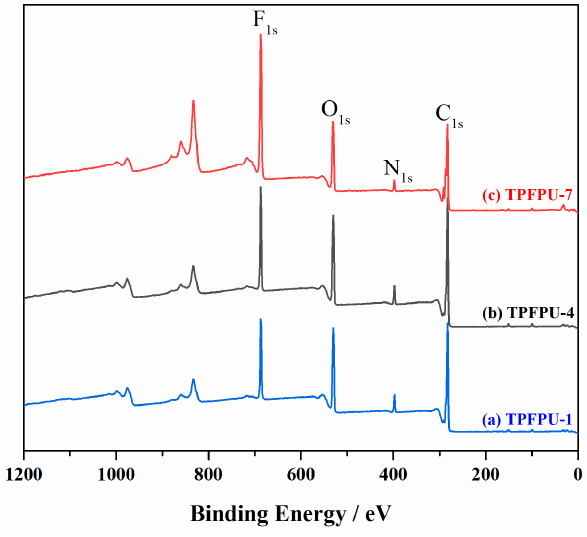
Figure 9. XPS survey spectra of ( a ) TPFPU-1, ( b ) TPFPU-4 and ( c ) TPFPU-7. Table 2. The theoretical and experimental atomic compositions of the TPFPU latex films.